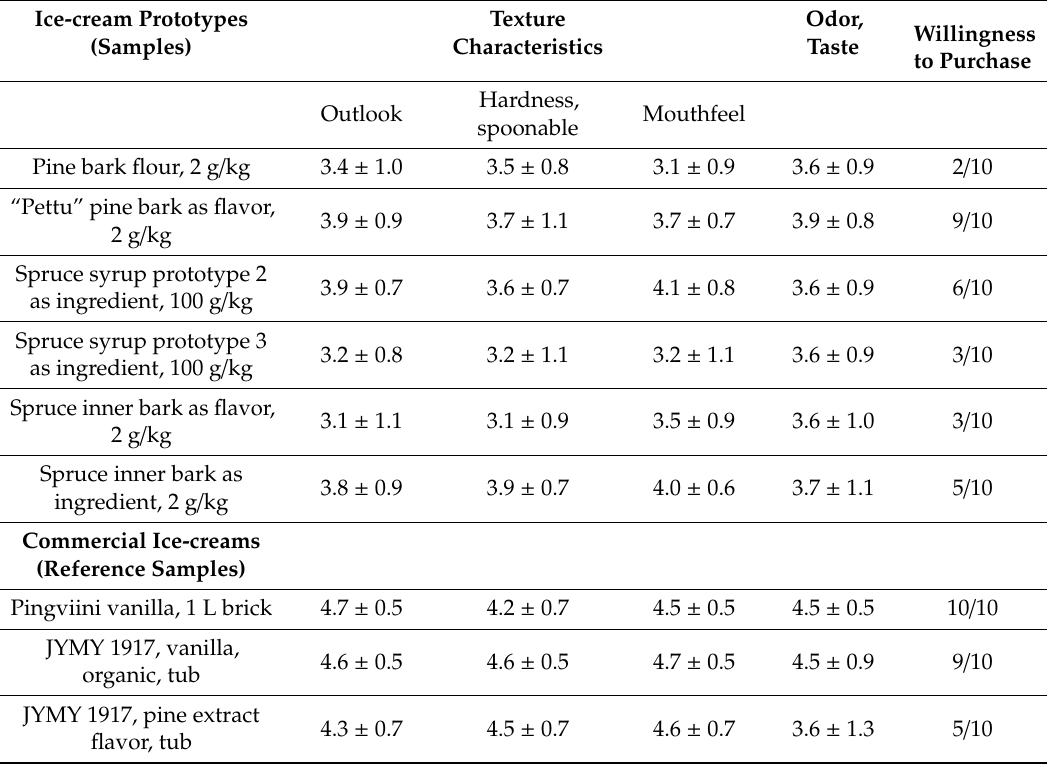
Table 4. Sensory evaluation and overall liking of prototype ice-creams and commercial ice-creams (used as a reference). Scores of 10 evaluators (x ± SD), evaluation scale 1–5 a